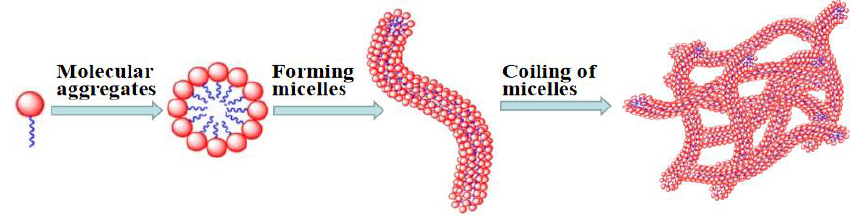
Figure 4. Schematic diagram of surfactant gel formation.